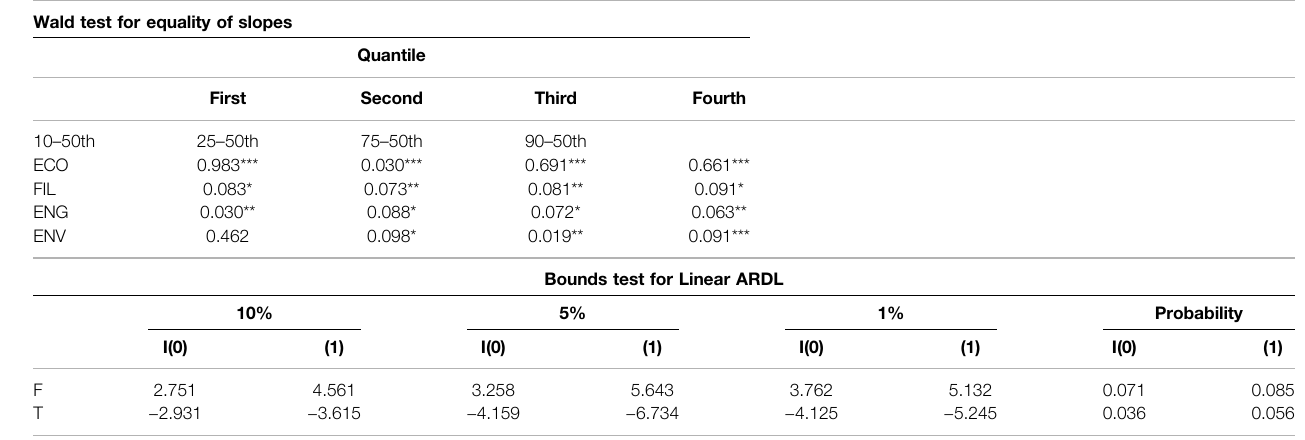
TABLE 7 | Diagnostic inspections with Wald & Bound